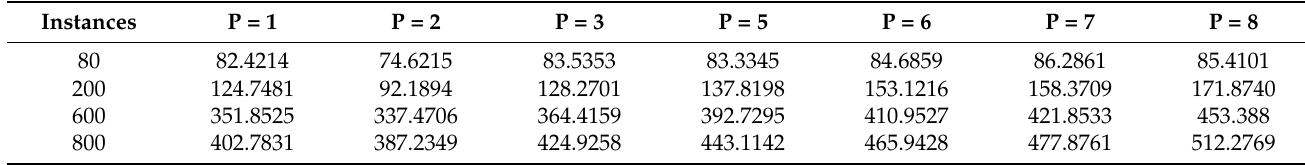
Table 10. Effects of different population numbers on the